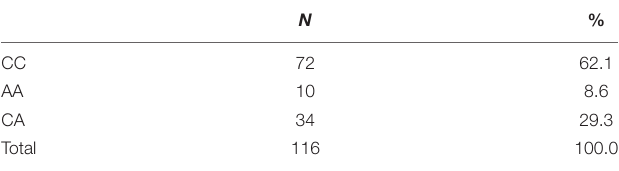
TABLE 4 | The genotype distribution of